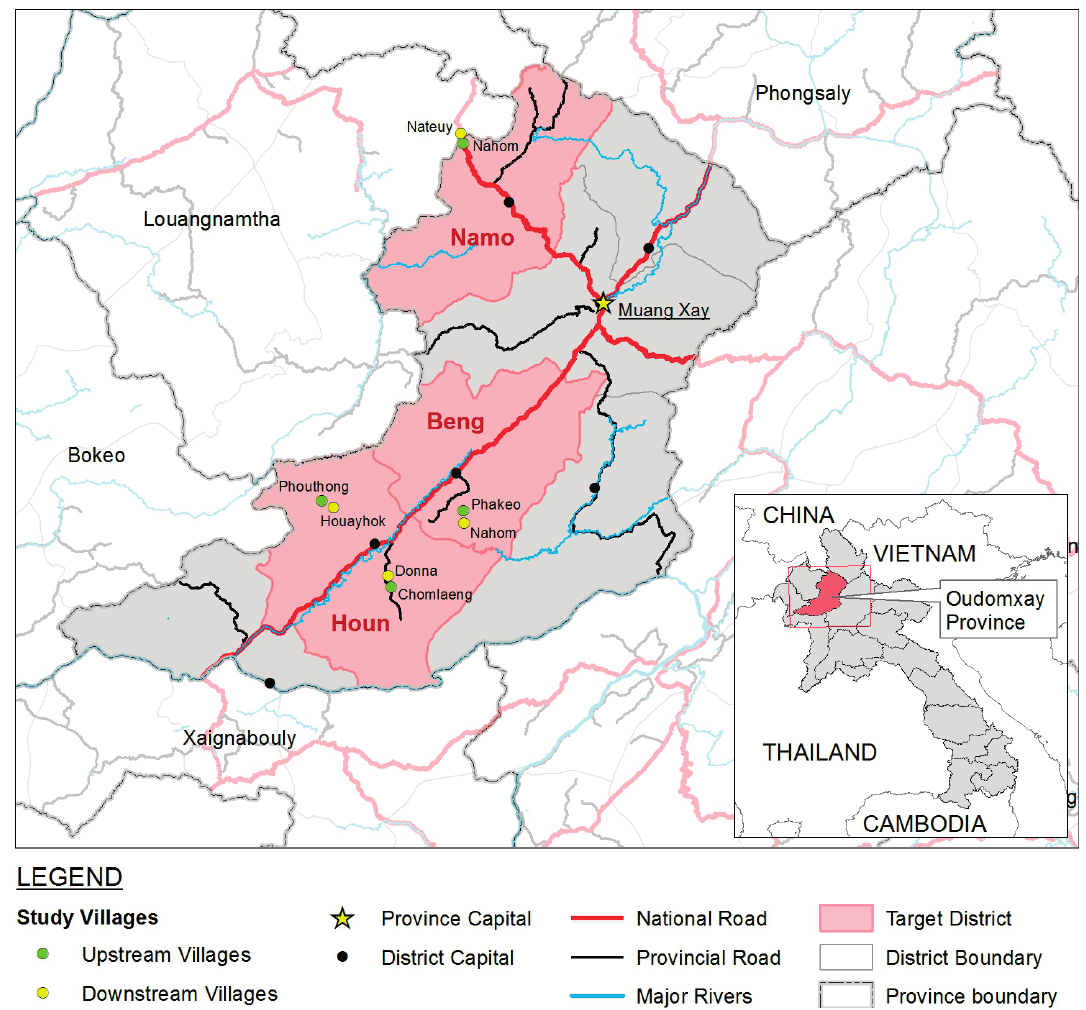
Figure 1. Location of Oudomxay province and research